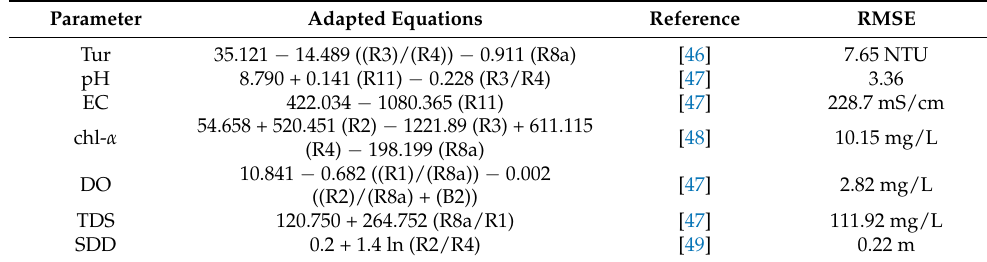
Table 3. Adapted equations for water quality